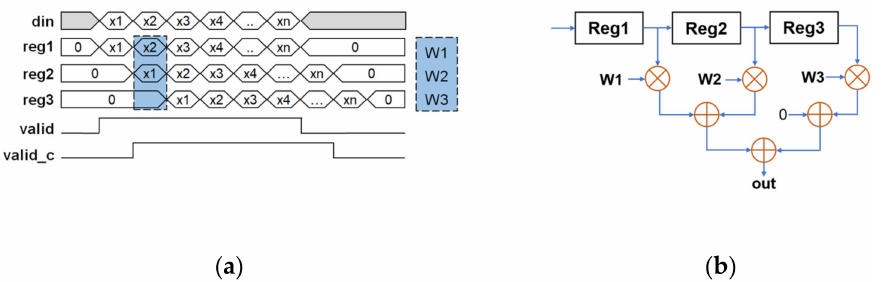
Figure 12. The structure of PE in the CK module. ( a ) PE’s timing diagram. ( b ) PE’s RTL circuit